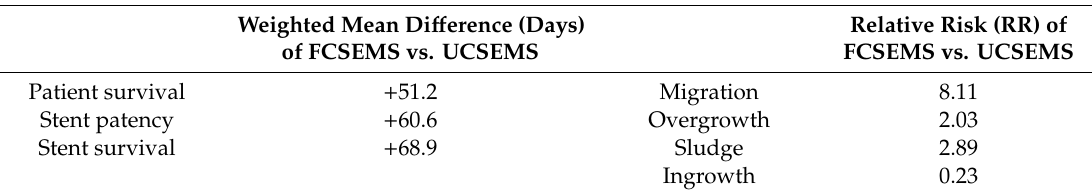
Table 2. Statistical comparison of self-expandable metallic stents: Fully-covered (FCSEMS) vs Uncovered (UCSEMS).